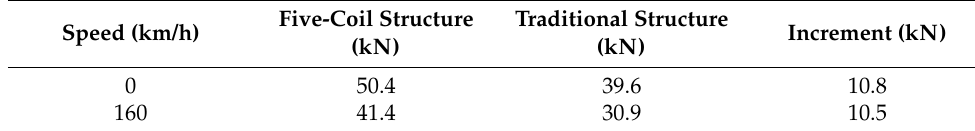
Table 6. Levitation Force of Five-coil Electromagnet Structure.